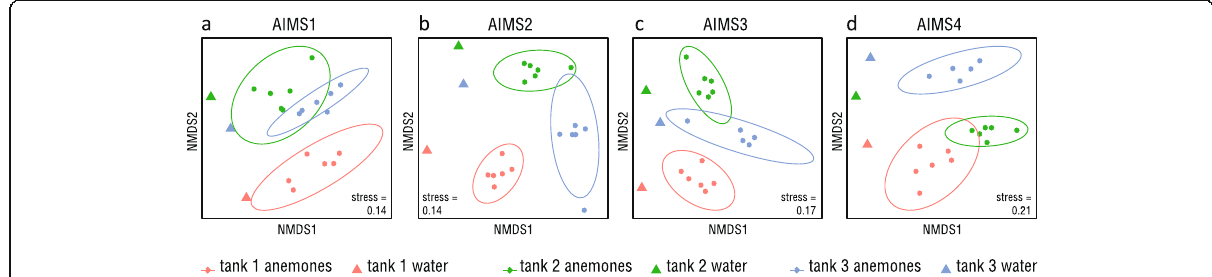
Fig. 5 Comparison of bacterial communities in water and anemones by nMDS on Bray-Curtis distances. AIMS1 ( a ), AIMS2 ( b ), AIMS3 ( c ), and AIMS4 ( d ). Ellipses indicate 95% confidence intervals